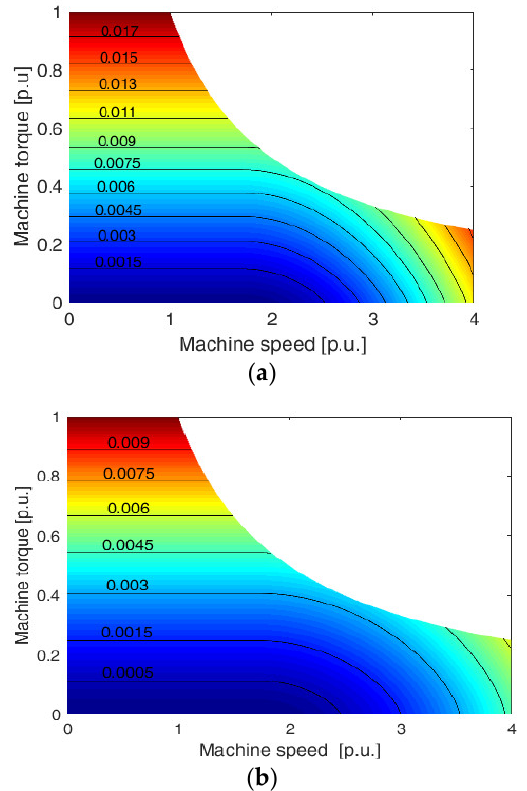
Figure 2. Inverter losses, ( a ) losses of a Si inverter (p.u.). ( b ) losses of a SiC inverter (p.u.).